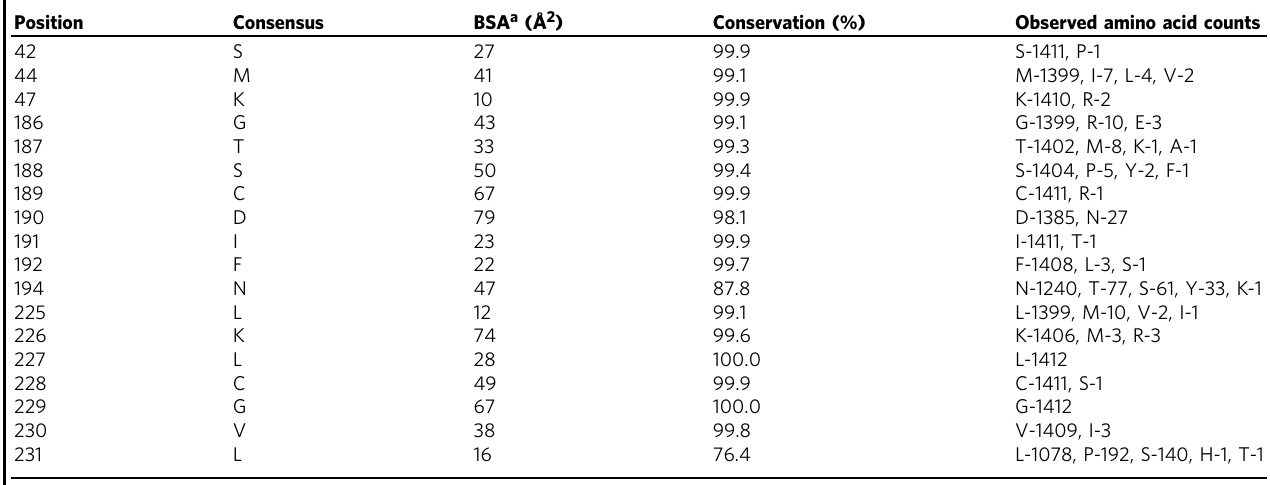
RABV G sequences in